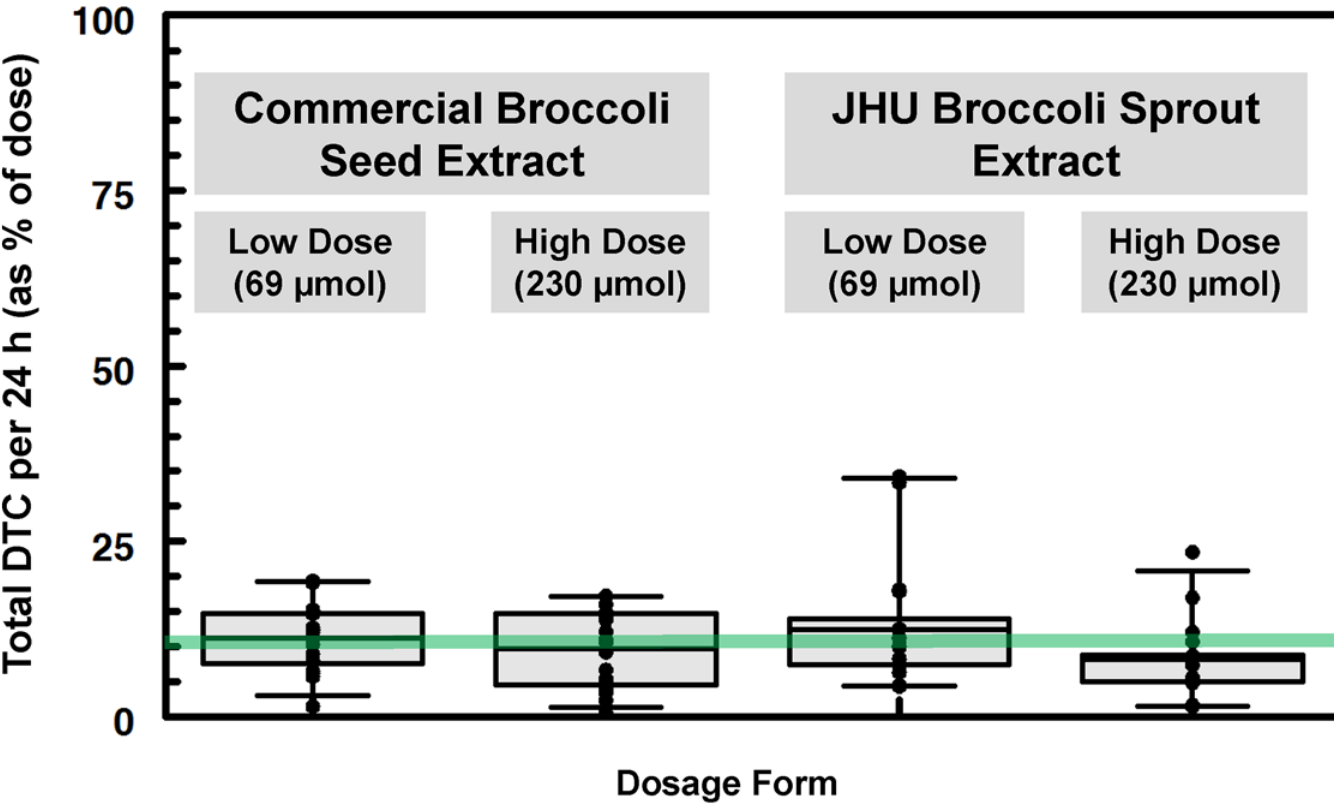
Fig 2. Mean daily excretion / conversion of GR-rich broccoli preparations to SF metabolites. Preparations are: Commercial broccoli seed extract (BSdE) formulated into gel-caps at 69 and 230 μ mol/dose (10.4% conversion overall; Table 1 , Cohort 3), and JHU BSE formulated (by Xymogen) into molar equivalent doses (10.3% conversion overall; Table 1 , Cohort 2). There is no difference among the treatment groups overall (p = 0.0651 by repeated measures anova)